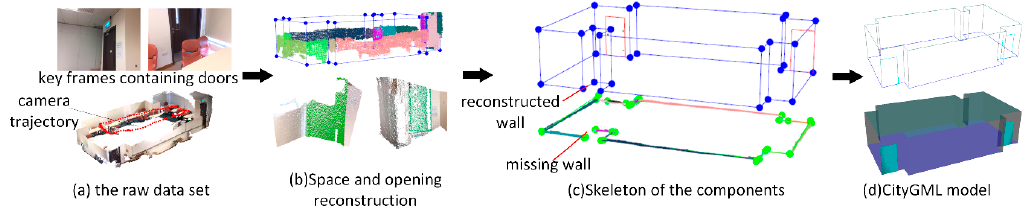
Figure 13. Reconstruction results for case study (2).